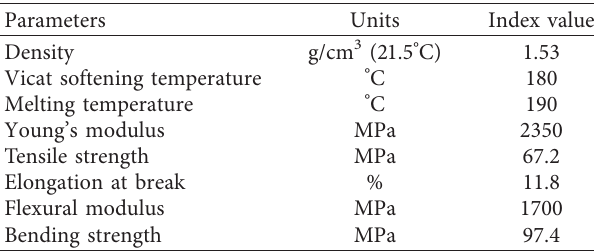
Table 3: Technical indicators of the nylon 6/66